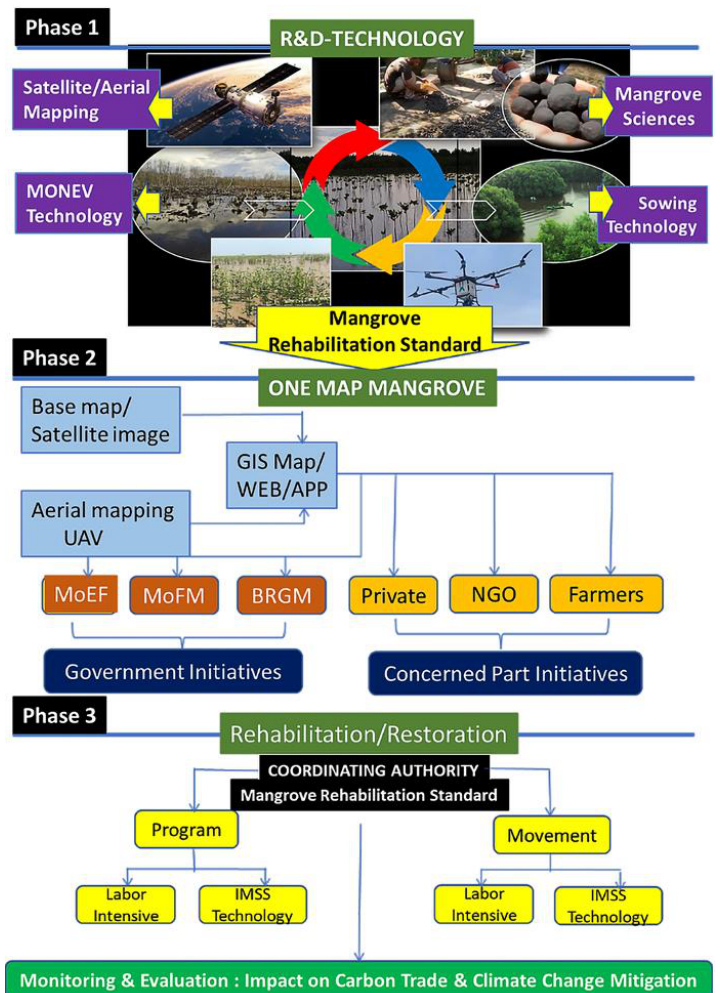
Figure 1. Advanced ecology-based mangrove rehabilitation strategy with the integrated mangrove sowing system (IMSS). UAV, unmanned aerial vehicle; GIS, geographic information system; NGO: non-government organization; MoEF, Ministry of Environment and Forestry; MoFM, Ministry of Fisheries and Maritime; BRGM, Peatland and Mangroves Restoration Agency.